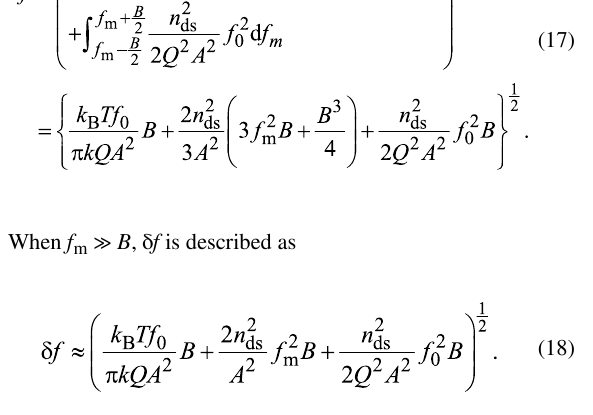
classical KPFM method. Moreover, we found that AC-KPFM can detect faster SPV responses (microseconds to milliseconds) depending on the modulation frequency of the laser